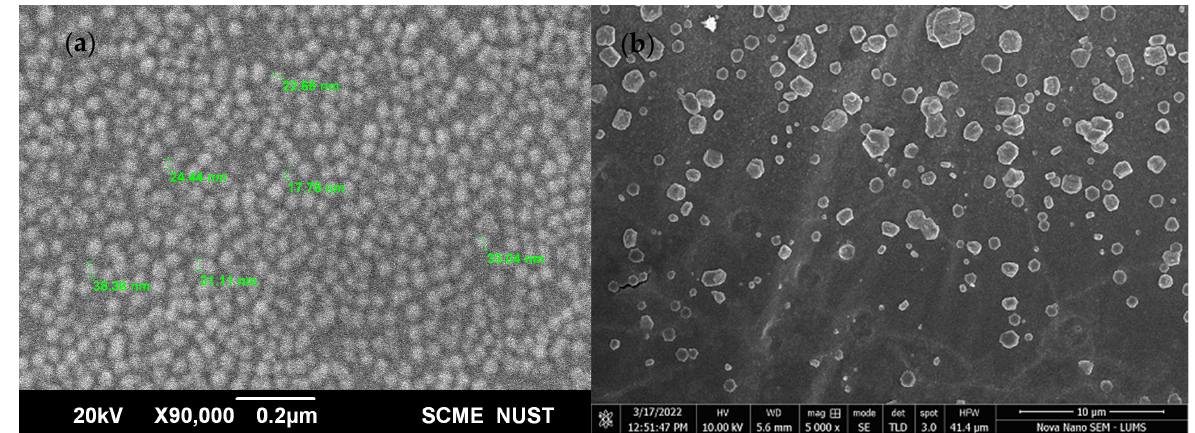
Figure 2. SEM images: ( a ) AgNPs and ( b ) DEAE-Dextran AgNPs.